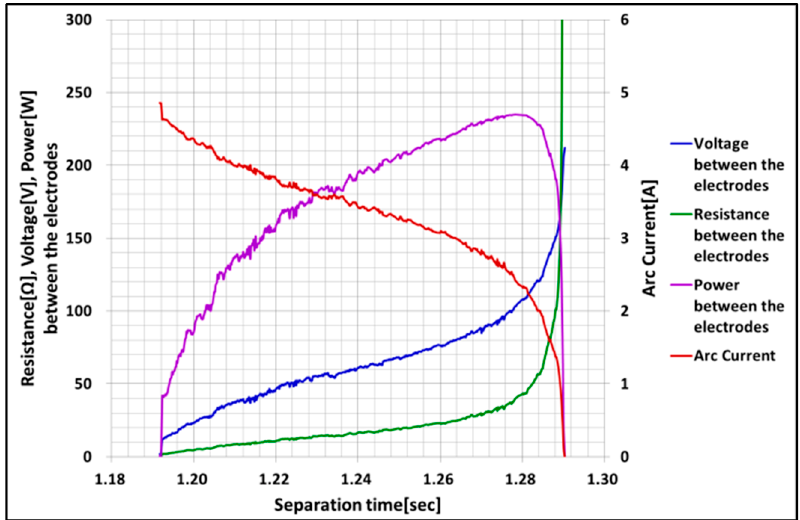
Figure 18. 200 V/5 A experimental results graph (arc power, arc voltage, arc current, arc resistance).